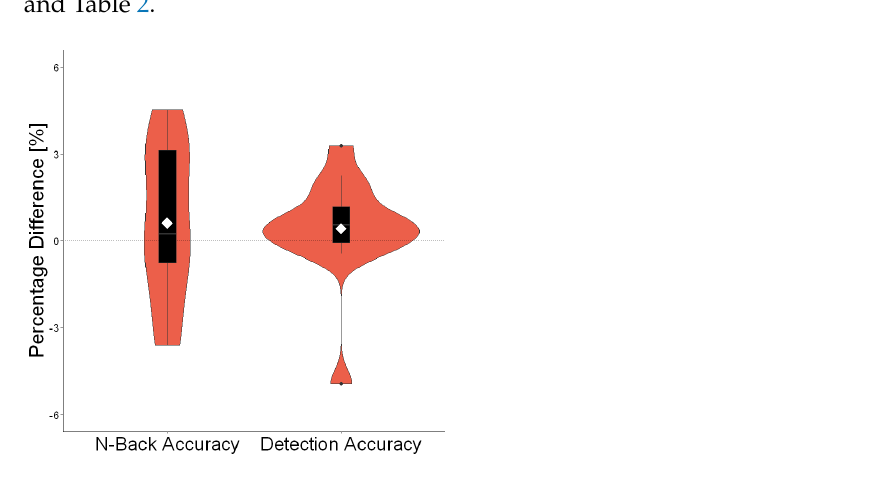
Figure 5. The relative difference for overall task accuracies in the n-Back and visual detection